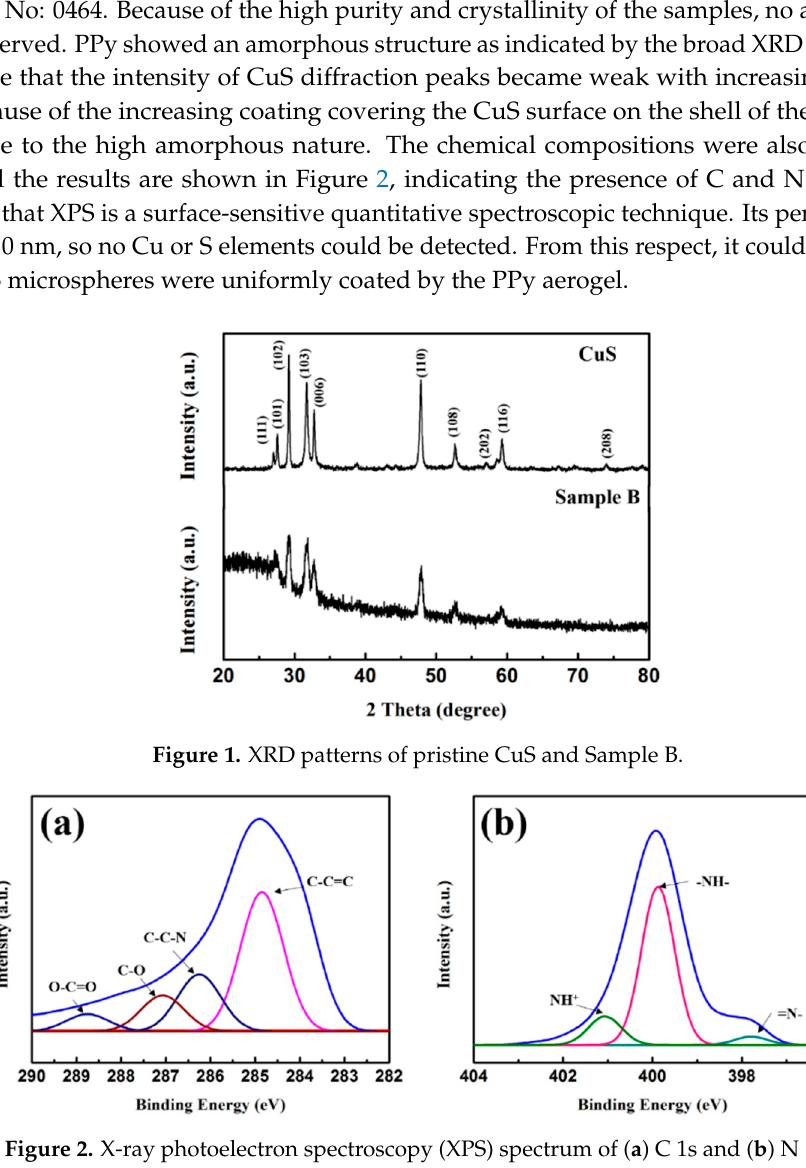
Figure 2. X-ray photoelectron spectroscopy (XPS) spectrum of ( a ) C 1s and ( b ) N 1s.